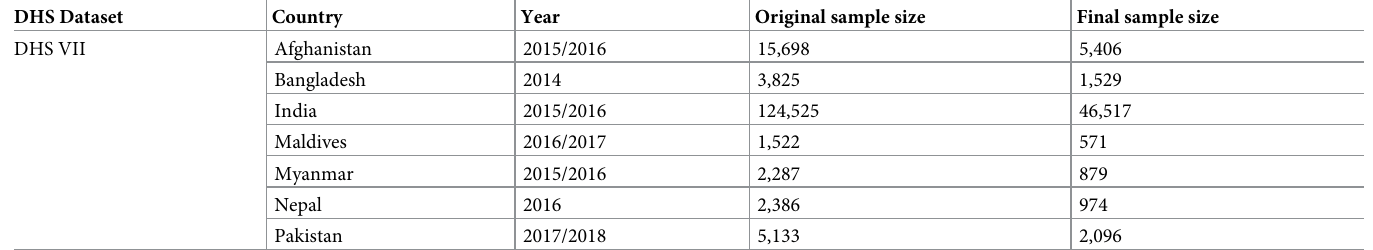
Table 1. DHS datasets and sample